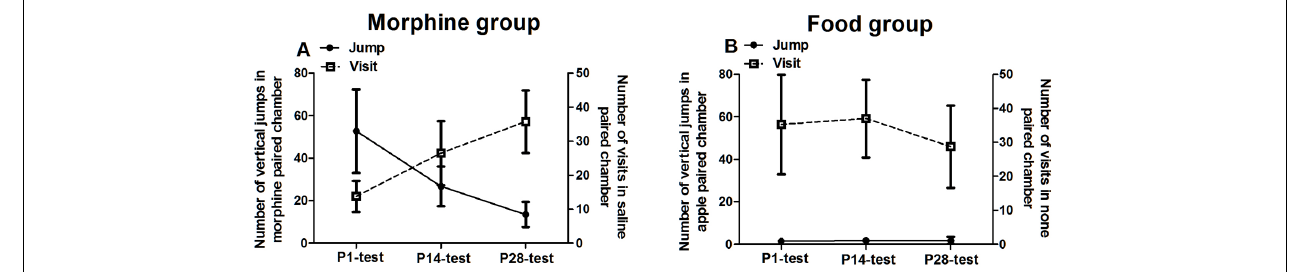
FIGURE 4 | Variations of psycho-activity and seeking behaviors during the abstinent state. The left y -axis showed the number of vertical jumps in morphine/food paired chamber and the right y -axis showed the number of visits to saline/no food paired chamber. (A) In morphine conditioned tree shrews, the jumps number in morphine-paired chamber expressed decreasing trend, however, the visits number in saline paired chamber expressed significantly increasing trend during abstinence. (B) In food-conditioned tree shrews, the number of jumps visits showed no change during the abstinent state. Data were expressed as means ± SEM, n =